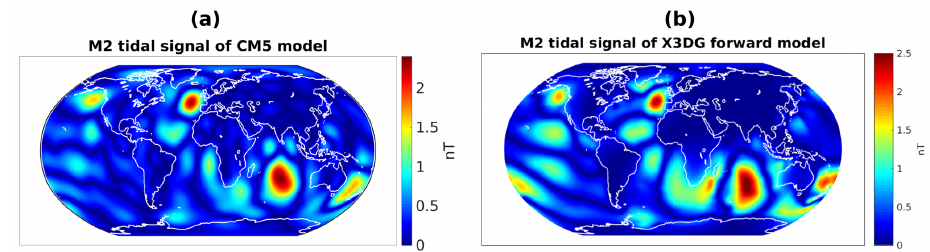
Figure 5. Absolute value of the radial part of the tidal model B CM5 oc as well as the forward model B X3DG oc at an altitude of 300km above the Earth’s surface.